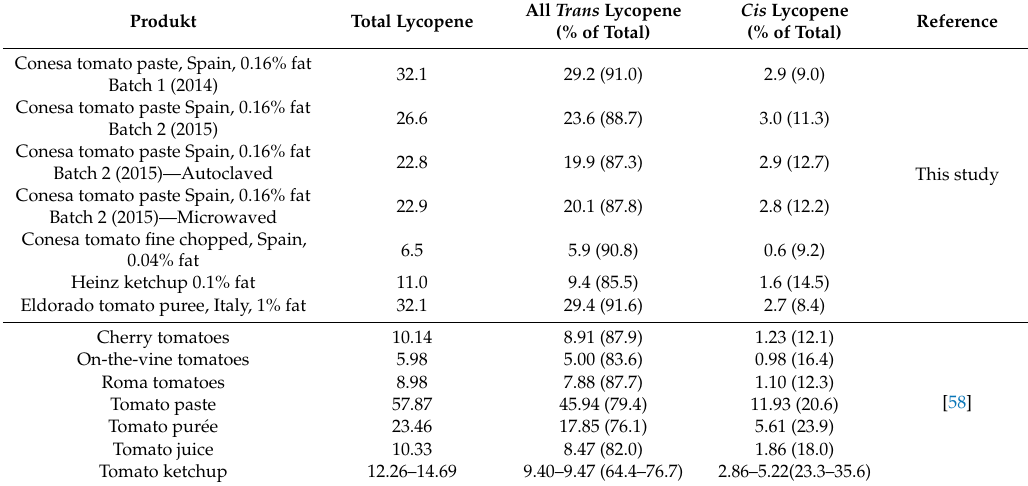
Table 5. Lycopene content (mg / 100 g FW) in tomato and tomato products including the fractions of trans - and cis -isomers. Produkt Total Lycopene